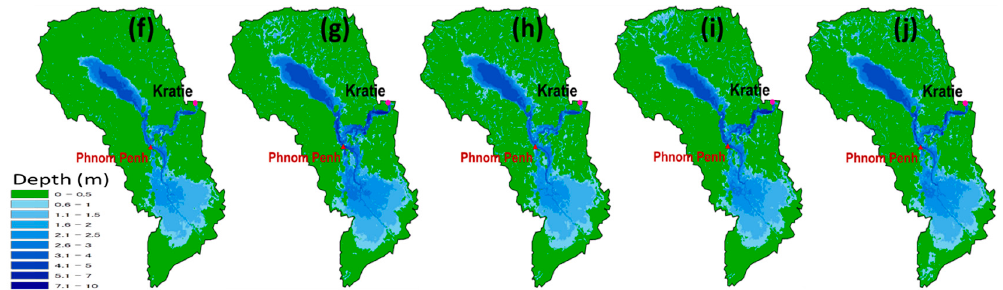
Figure 8. Maximum inundation out of 25 years simulation: ( f ) SPA_m01; ( g ) SFA_rcp85; ( h ) SFA_ rcp85-c1; ( i ) SFA_ rcp85-c2 and ( j ) SFA_ rcp85-c3. Table 2. Comparison of present and future hydrological features of the